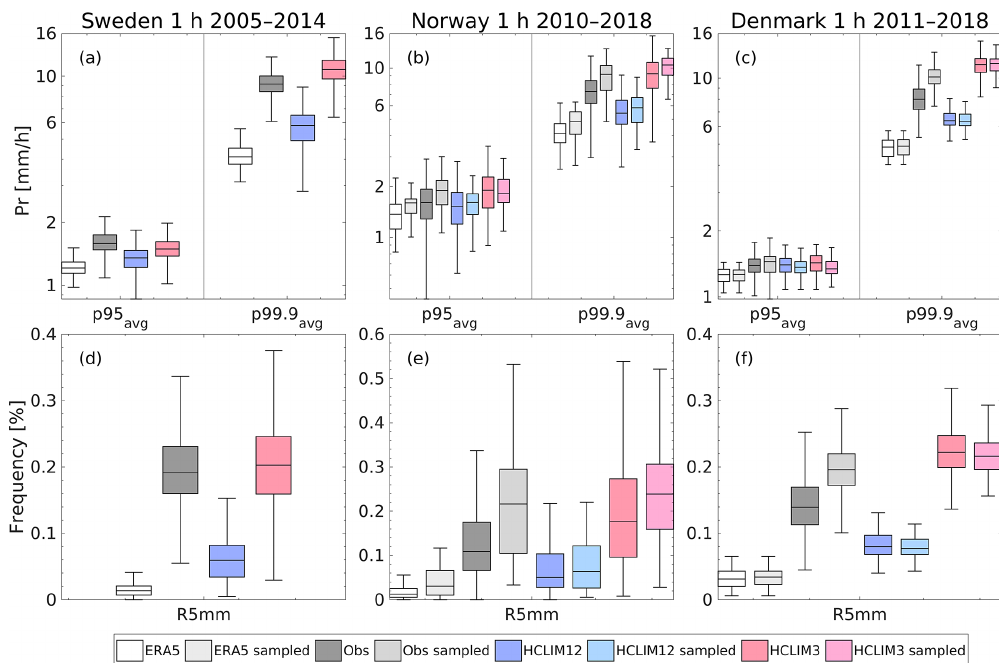
Figure 5. (a–c) Same as in Fig. 3 but for average hourly precipitation over the 95th and 99.9th percentiles (p95 avg and p99 . 9 avg ) in (a) Swe- den, (b) Norway, and (c) Denmark in HCLIM12, HCLIM3, and observational high-resolution national datasets. Please note the logarithmic scale of the y axis. (d–f) The frequency of hours with heavy (R5mm) precipitation in HCLIM12, HCLIM3, and observational datasets in (d) Sweden, (e) Norway, and (f) Denmark. The label of Obs refers to the national high-resolution gridded datasets. The label of sampled refers to the results with geographic sampling.